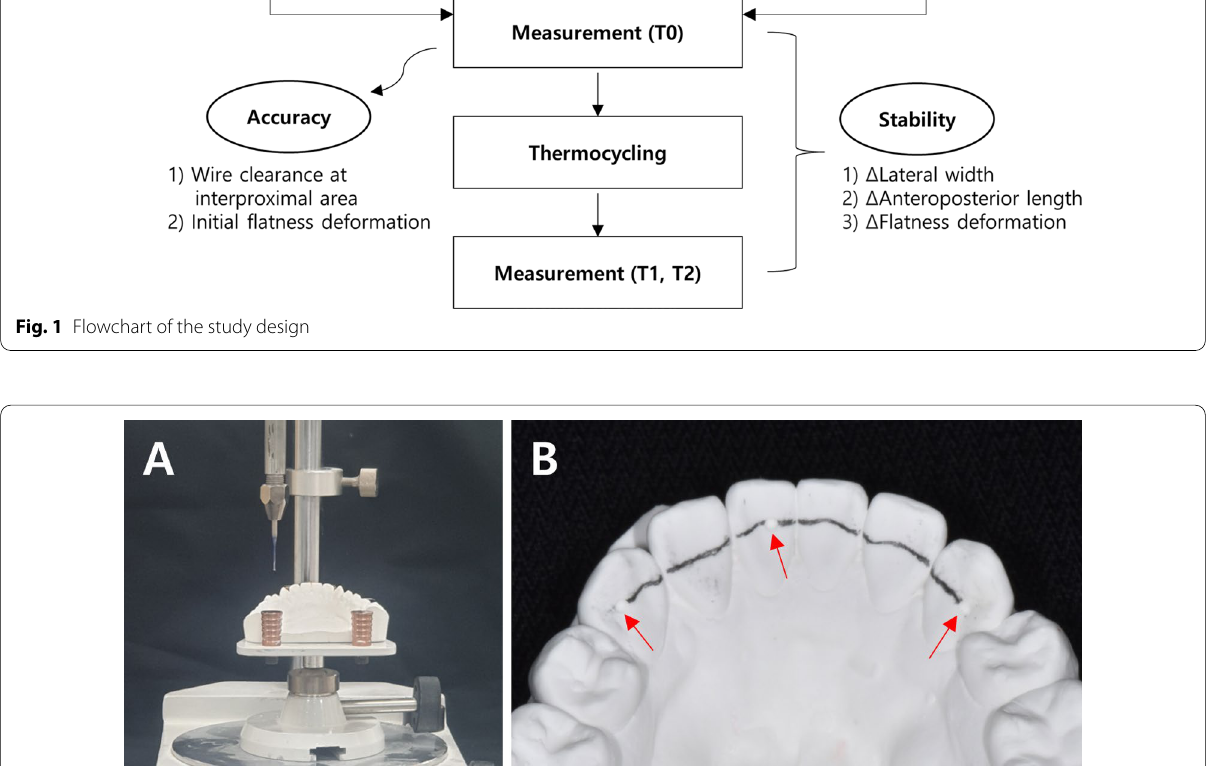
located on one plane of the dental models but bypass the interior of the dimples. The fabricated retainer was cut at the mesial side of the dimple formed on both canines.